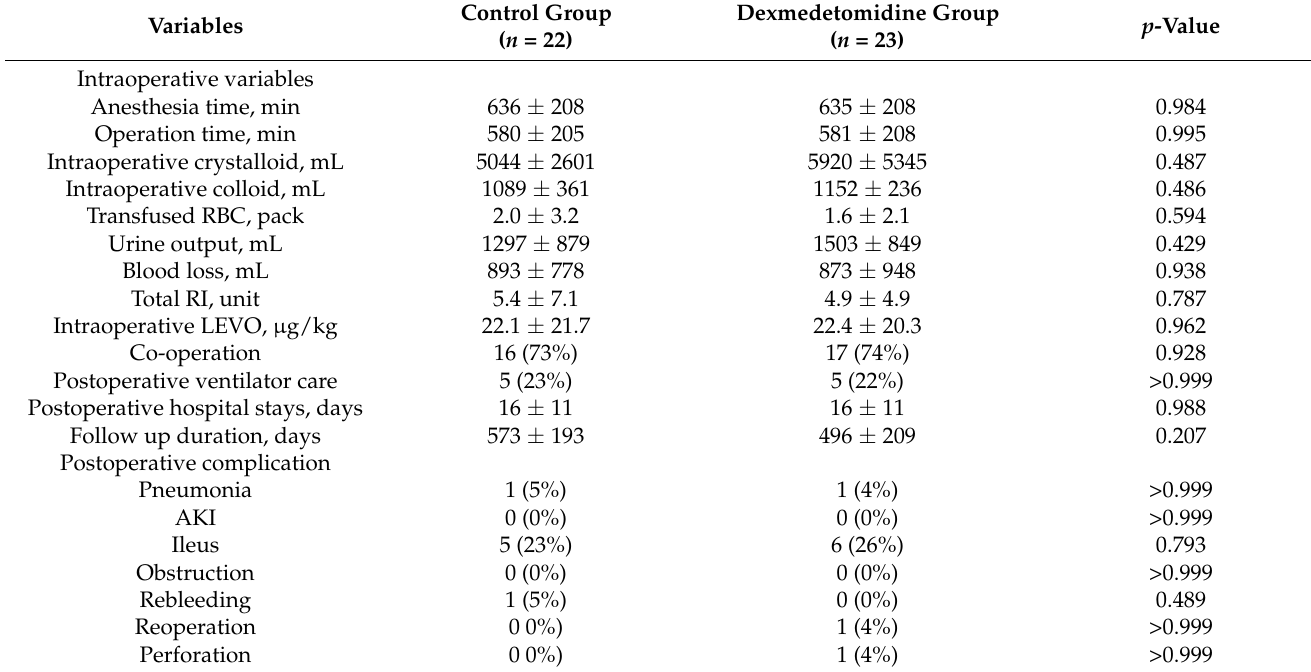
Table 2. Perioperative